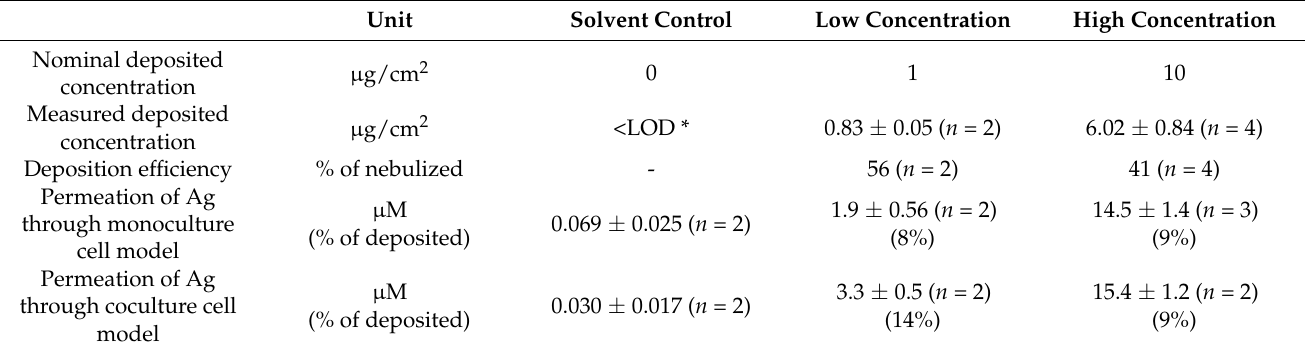
Table 1. Deposition and permeation of Ag in mono- and cocultures exposed to an aerosol of NM- 300K. Control was exposed to NM-300K DIS. Results are presented as mean with SD. Deposition was measured in 2 or 4 independent experiments with 2–3 replica inserts in each experiment. Permeation was measured in 2–3 independent experiments, each with 1–2 replica inserts. Maximum permeation of NM-300K at high concentration through empty inserts was 7% (11 µ M, n = 2). * Control was insert membranes without Ag deposition. LOD, limit of detection; SD, standard deviation. Unit Solvent Control Low Concentration High